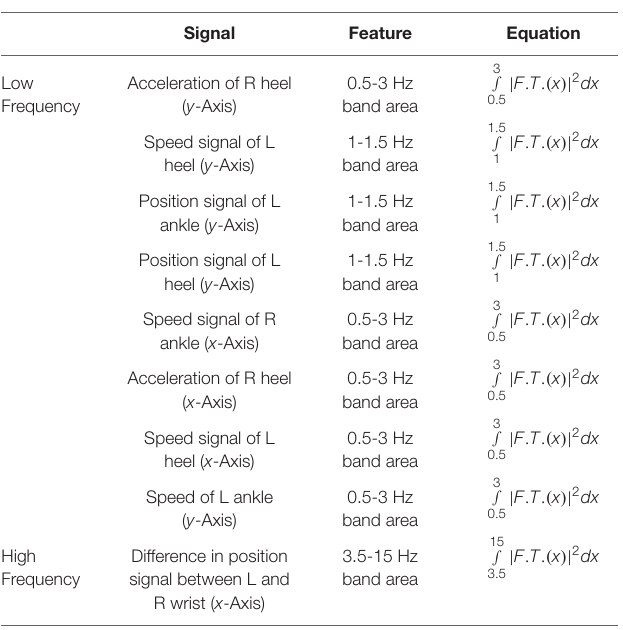
TABLE 8 | The low-frequency and high-frequency features for the Walk-FOG recognition model and Turn-FOG recognition model.